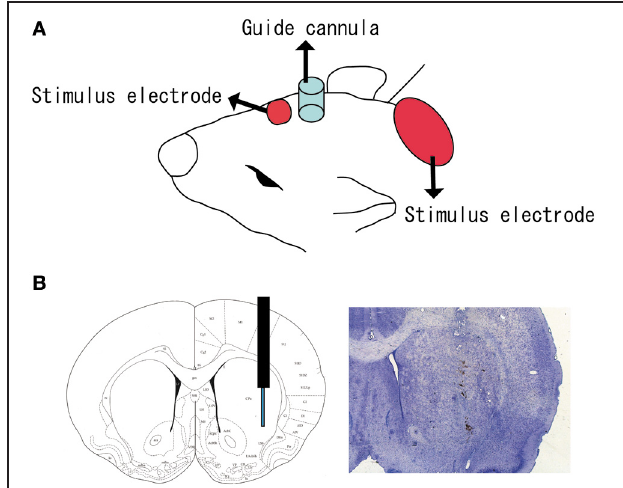
FIGURE 1 | Position of tDCS electrode and microdialysis probe. (A) One electrode (small red square) of the stimulator was fixed to the skin with surgical tape just above the brain region including the cortex. The anatomical location corresponded to + 2.0 to + 7.0mm anterior and + 1.0 to + 6.0mm lateral to the bregma. A second electrode (large red ellipse) was placed on the neck. A guide cannula (blue cylinder) was fixed to the skull with resin dental cement; (B) a microdialysis probe was inserted into the striatum ( + 1.0mm anterior, + 3.5mm lateral, and − 4.5mm ventral to the